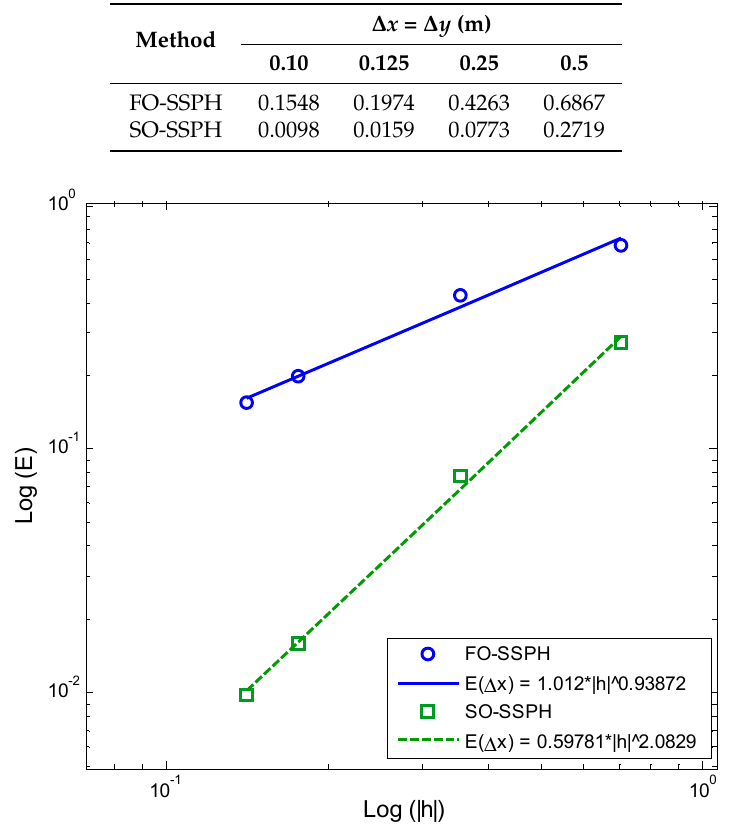
Table 3. Errors of FO-SSPH and SO-SSPH for two-dimensional heat conduction with discontinuous initial distribution.